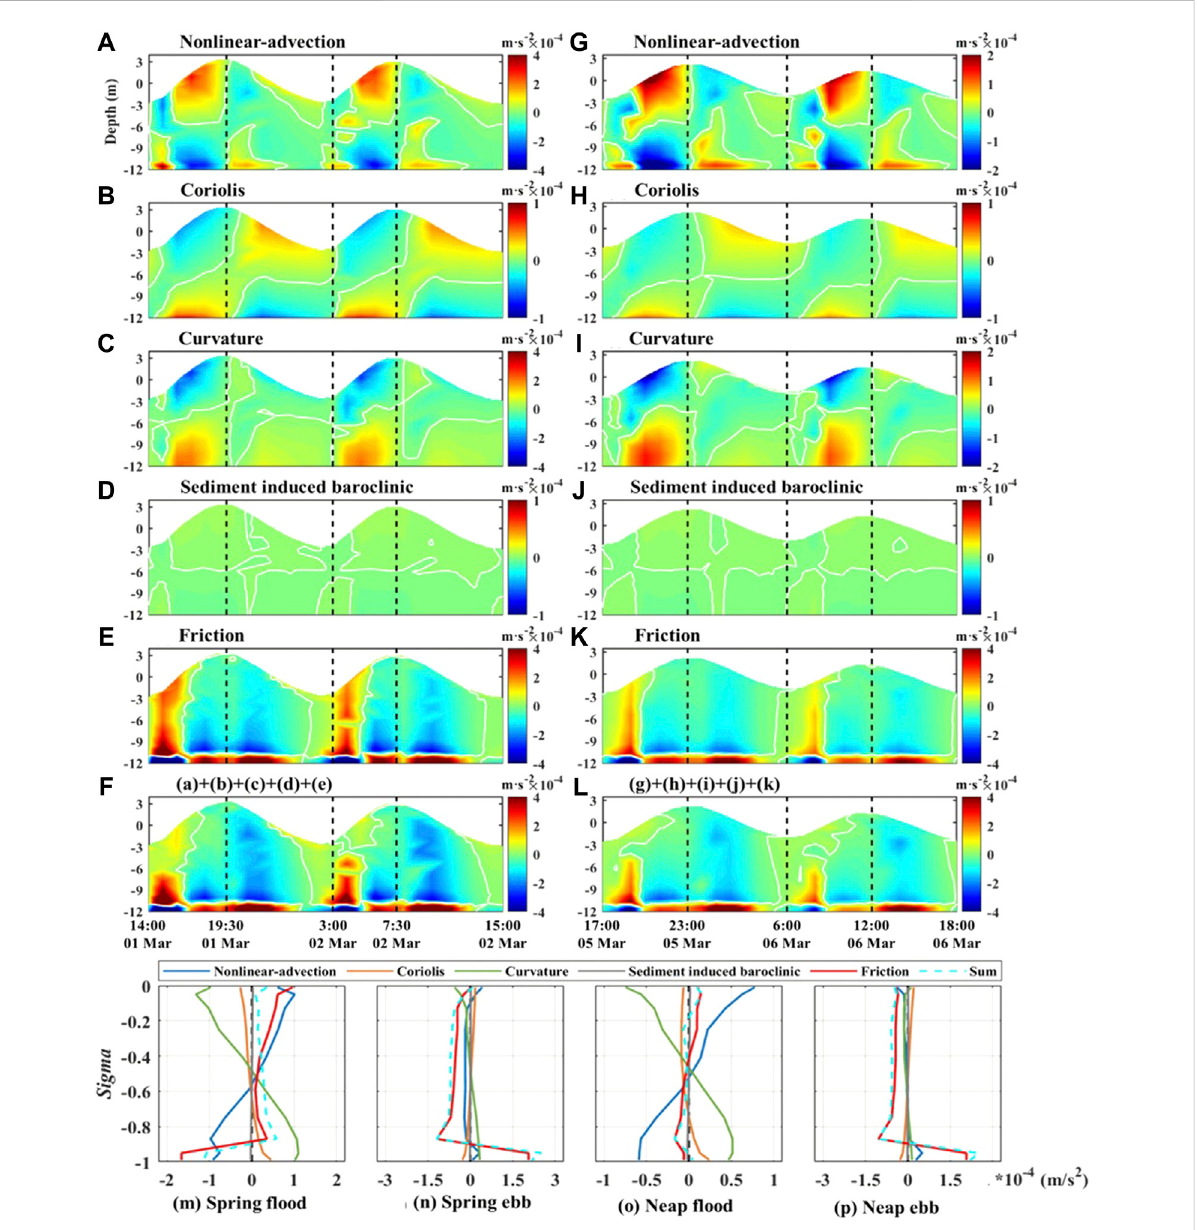
spring fl ood and (N) spring ebb tides. (O – P) Depict the same as (M – N) except for neap tides. Positive values indicate southward